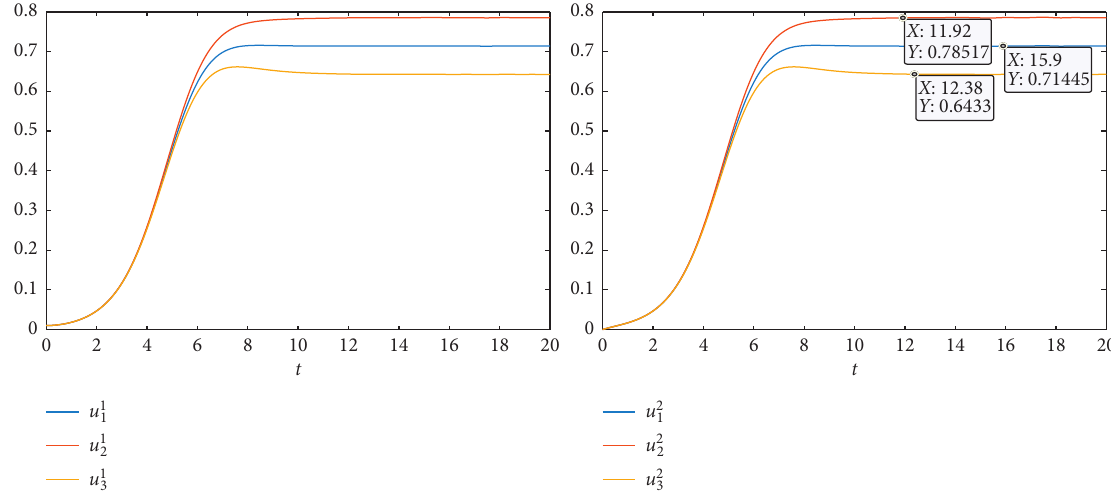
Figure 1: Simulation of (39) with